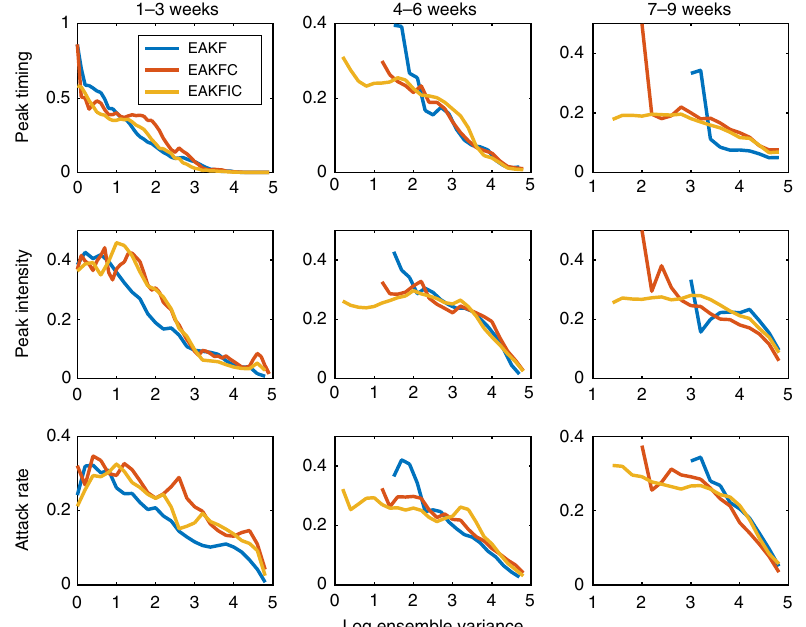
Fig. 4 Prediction accuracy of peak timing, peak intensity and attack rate vs. the log ensemble variance of peak predictions. All predictions are fi rst grouped by predicted lead time: 1 – 3 weeks (left column), 4 – 6 weeks (middle column), and 7 – 9 weeks (right column). Predictions in each category are then sorted according to the within ensemble log variance of forecast peak weeks in an ascending order. The average prediction accuracy for peak timing ( ± 1 week), peak intensity ( ± 25%) and attack rate ( ± 25%) are displayed in the upper, middle and lower row